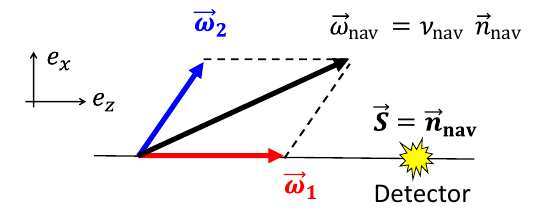
Fig. 2 Diagram of the partial fields of an SN with two solenoids field integrals of the solenoids grow proportionally to the beam momentum. A solenoid field integral of 10 T · m allows for setting a navigator spin tune of 0.013 for protons and 0.004 for deuterons at the beam momentum of 100 GeV/c.